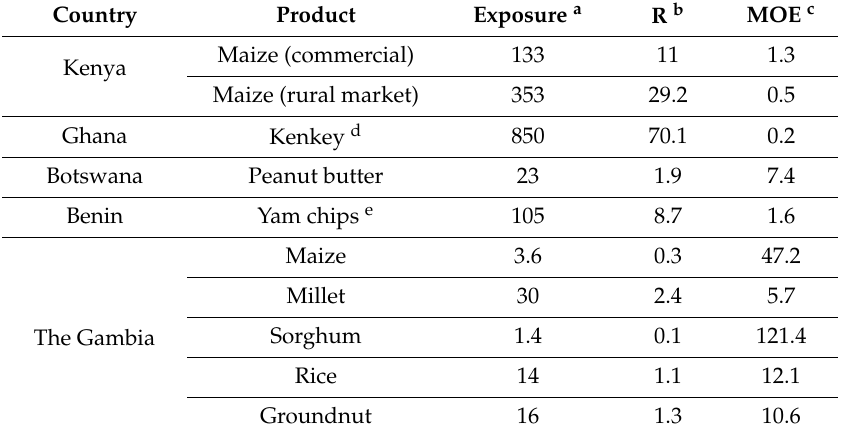
Table 8. Risk for primary liver cancer (hepatocellular carcinoma) in some African countries determined by the deterministic approach as function of the exposure from di ff erent food products and the carcinogenic potency or by the margin of exposure (MOE) using the benchmark dose (BMD) approach. Adapted from